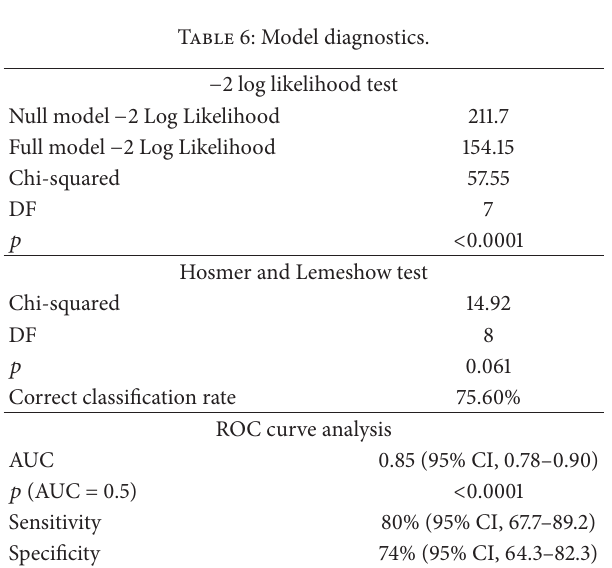
Table 6: Model diagnostics.